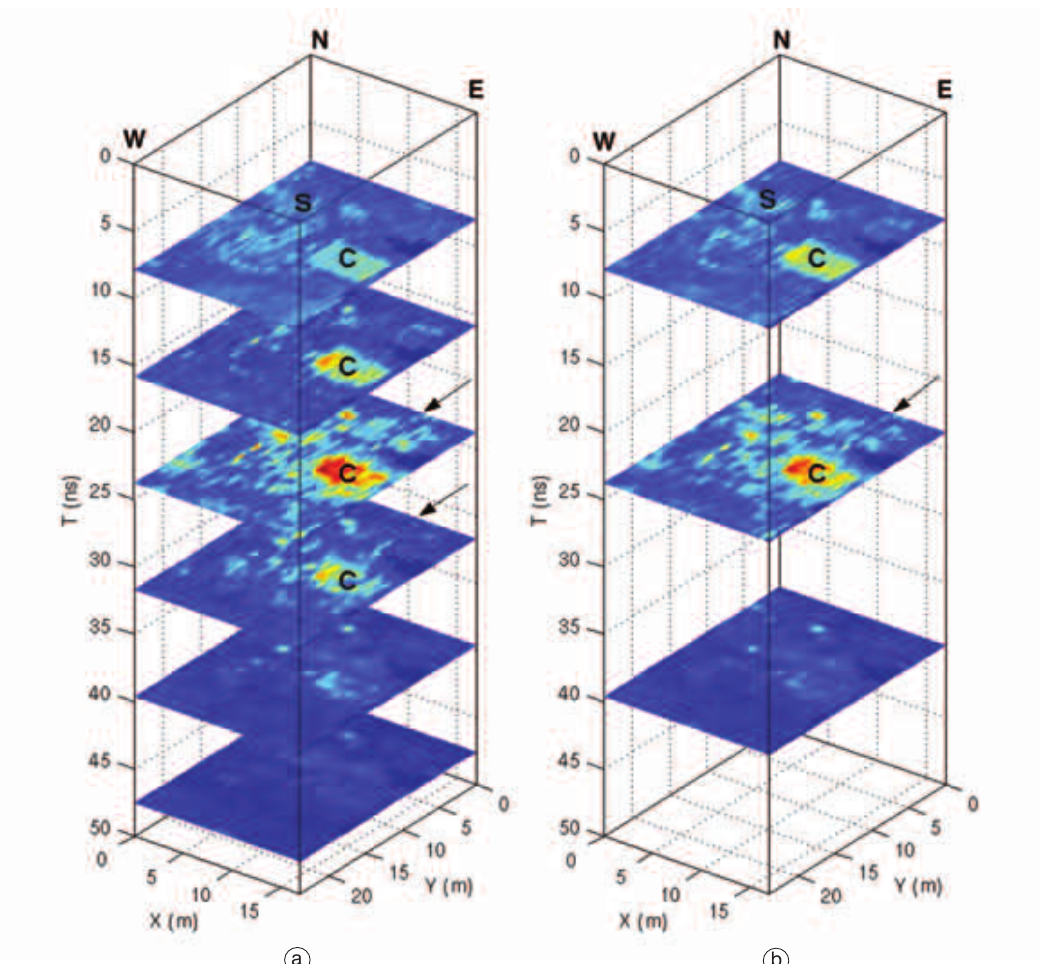
Fig. 5a,b. Zone D. Time slices obtained averaging the absolute amplitude of the data within different time windows: 8 ns (a) and 16 ns (b). The strong rectangular anomaly C is probably related to an old refilled cistern; arrows denote a weak and thin linear anomaly probably due to a ditch in the